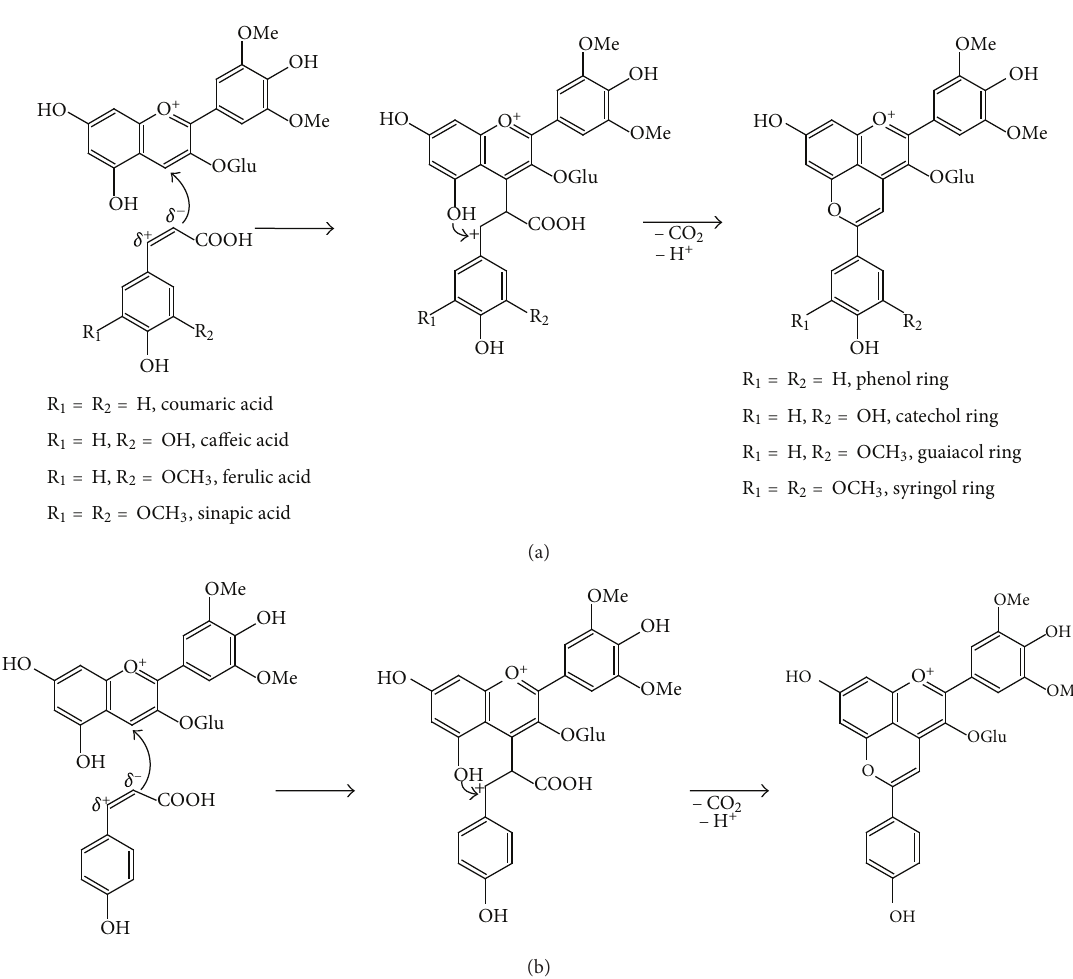
F 6: Formation reaction of pinotins from hydroxycinnamic acids (a) and formation of pyranomalvidin-3- O -glucoside-phenol (b) [59,